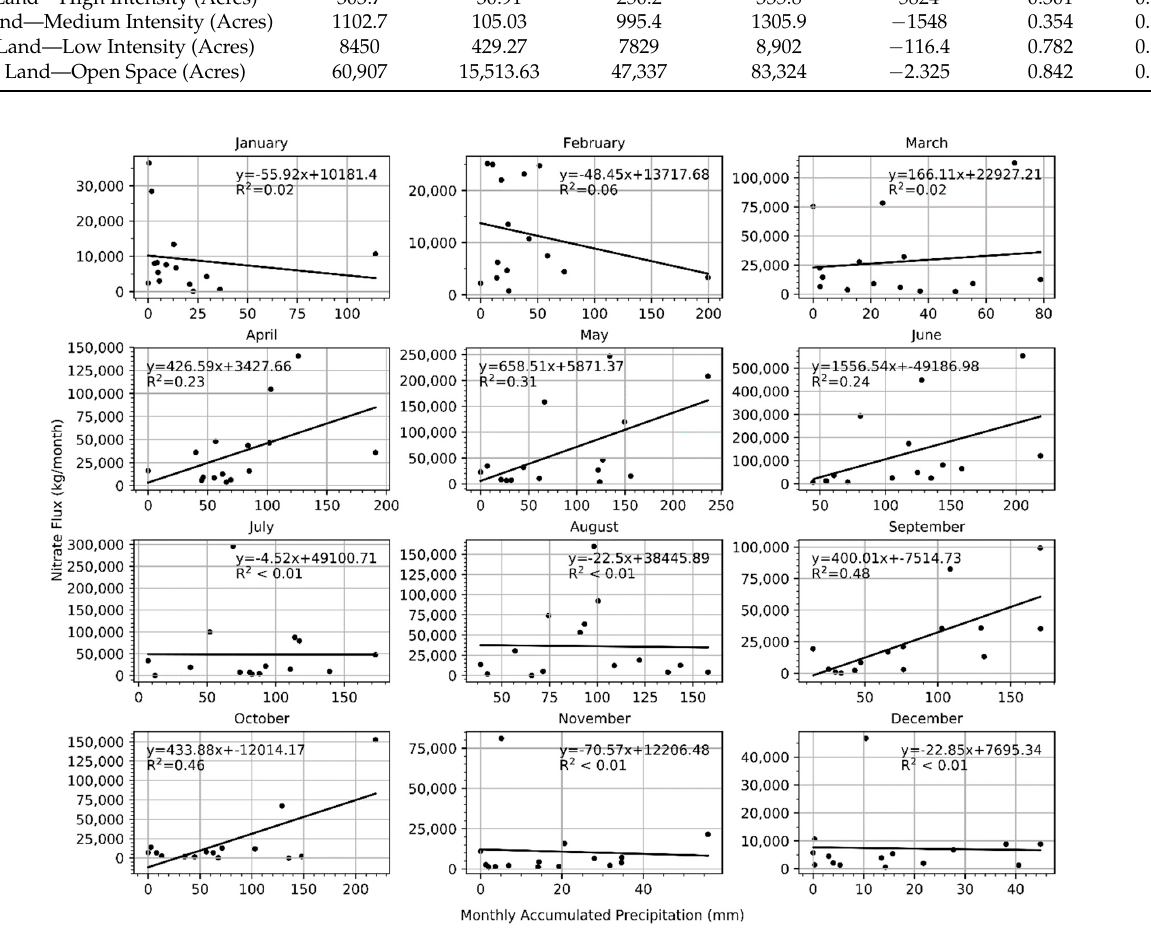
Figure A1. The relationship between the mean monthly nitrate flux for a given month and the total precipitation for that month.